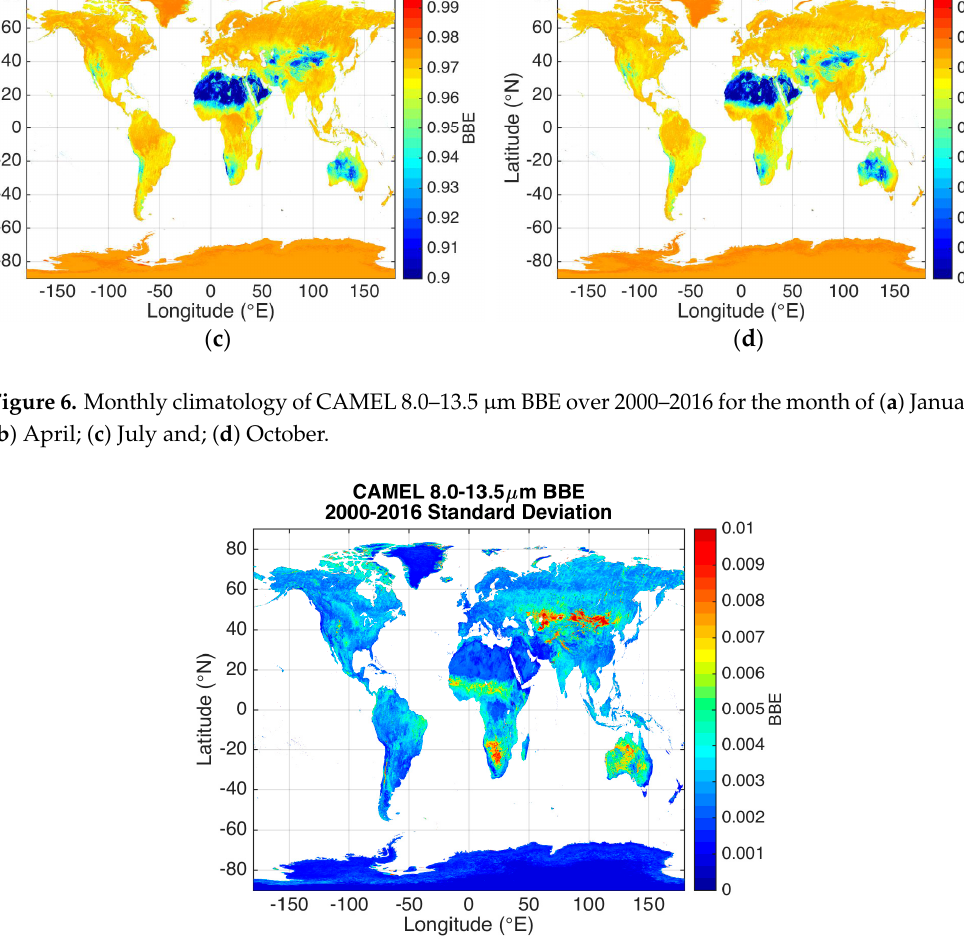
Figure 7. Standard deviation of monthly, 8.0–13.5 µm CAMEL BBE over the years 2000–2016 highlights geographic regions which have larger temporal variations in BBE.